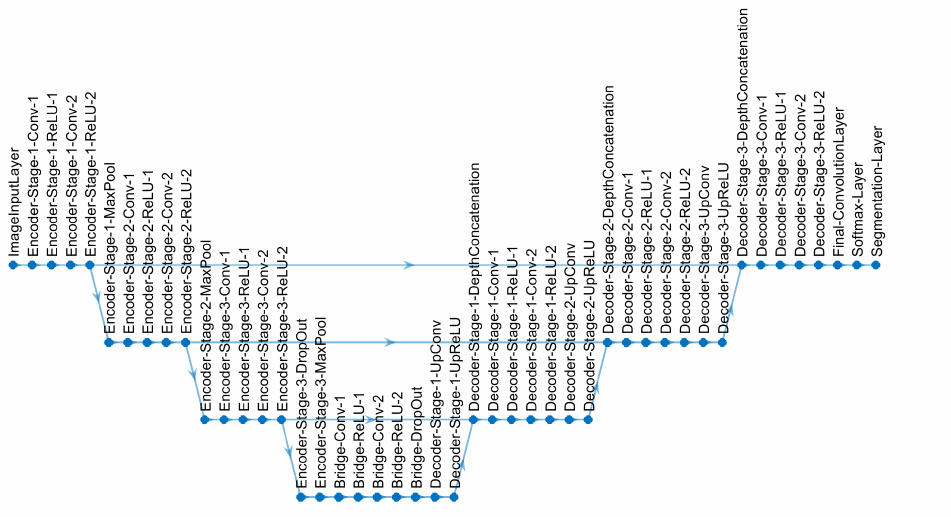
Figure 5. U-Net architecture used for semantic segmentation in this work. Each level consists of a series of operations: convolutions (abbreviated as Conv), non-linear operations (rectified linear unit or ReLU) and subsampling (MaxPool). The data are first reduced in resolution (going down in the diagram) and then expanded (going up) to return to the same level of the input image.